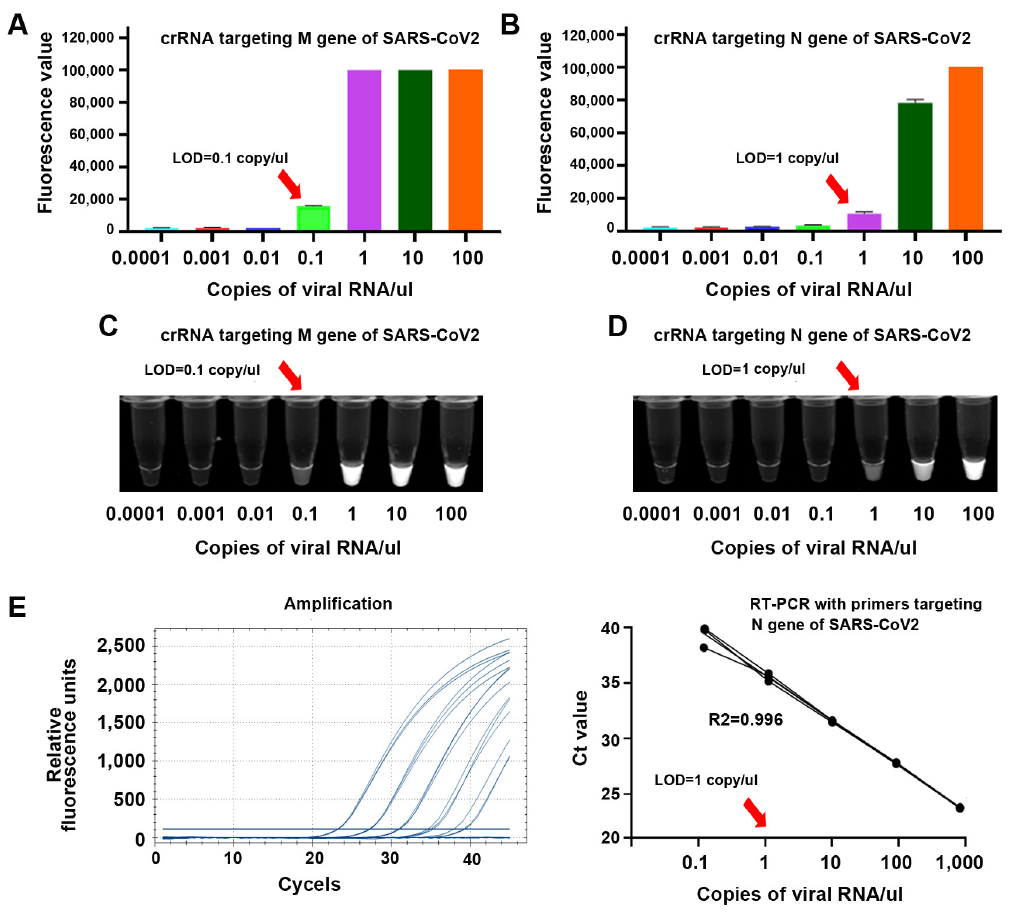
Figure 4. The sensitivity of CRISPR-Cas12a and RT-PCR for detecting SARS-CoV-2 in serially diluted RNA of SARS-CoV-2 samples. When the results were read by a fluorescence plate reader, the limit of detection (LOD) of CRISPR-Cas12a with specific crRNA against M ( A ) and N ( B ) was 0.1 copy/ µ L/and 1 copy/ µ L, respectively. When the results were ready by a UV light illuminator, the LOD of CRISPR-Cas12a with specific crRNA against M ( C ) and N ( D ) was also 0.1 copy/ µ L/and 1 copy/ µ L, respectively. RT-PCR analysis of N gene of SARS-CoV-2 in the same serially diluted samples had LOD of 1 copy/ µ L ( E ) for detecting the virus.